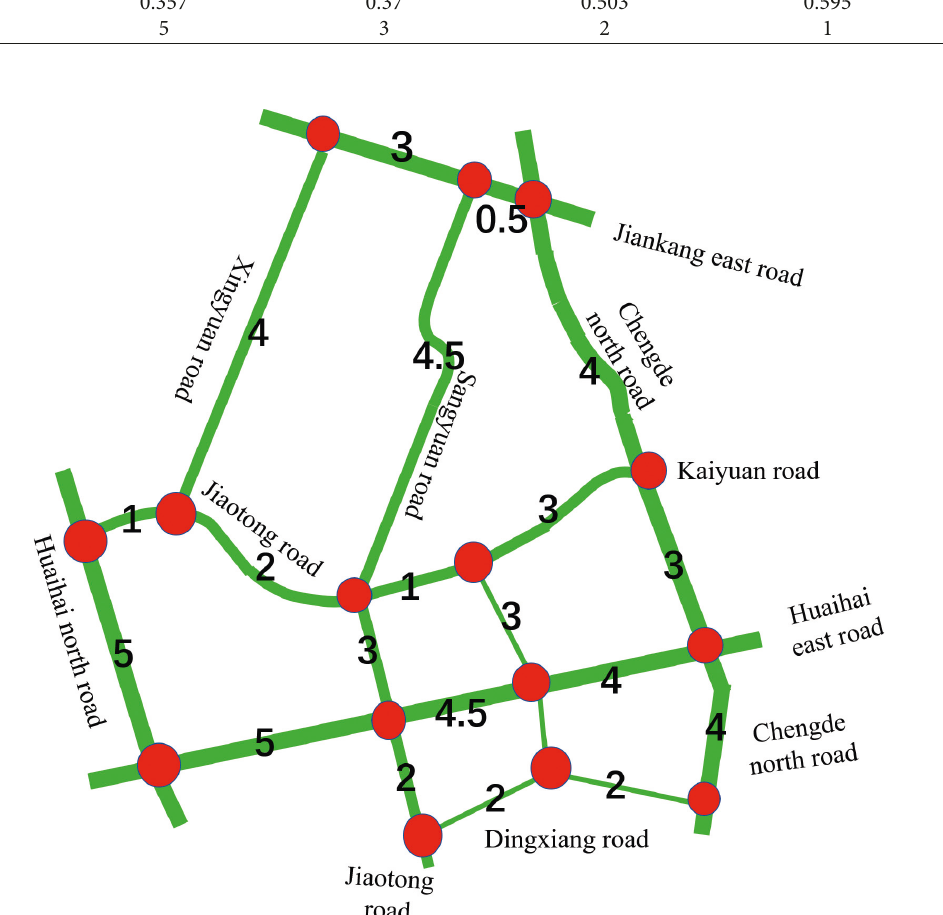
Figure 4: Road network with travel time (Unit: